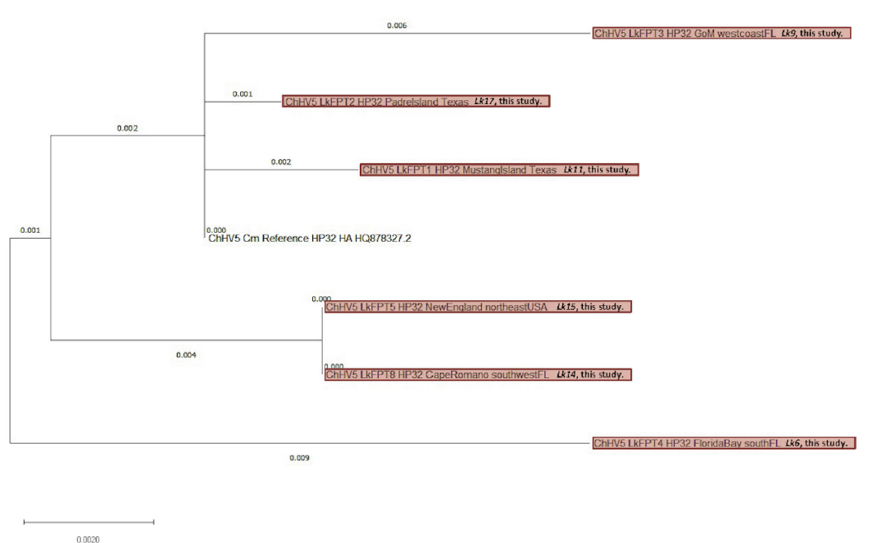
Figure 8. Phylogenetic analysis of chelonid alphaherpesvirus 5 (ChHV5) hypothetical protein-32 (HP32) consensus gene obtained from six Kemp’s ridley sea turtle ( Lepidochelys kempii ) tumor samples, along with the reference HP32 gene from the NCBI GenBank database (GenBank accession: HQ878327.2) sequenced from a green turtle ( Chelonia mydas ) in Hawaii. Generated sequences denote the geographic location of each turtle. Sequences match the length and position of the reference gene (1,685 bp) for direct phylogenetic comparison. The tree is drawn to scale, with branch lengths measured in the number of substitutions per site. Samples generated as part of the current study are shaded red. Abbreviations: Cm, C. mydas ; Lk, L. kempii ; HA, Hawaii.